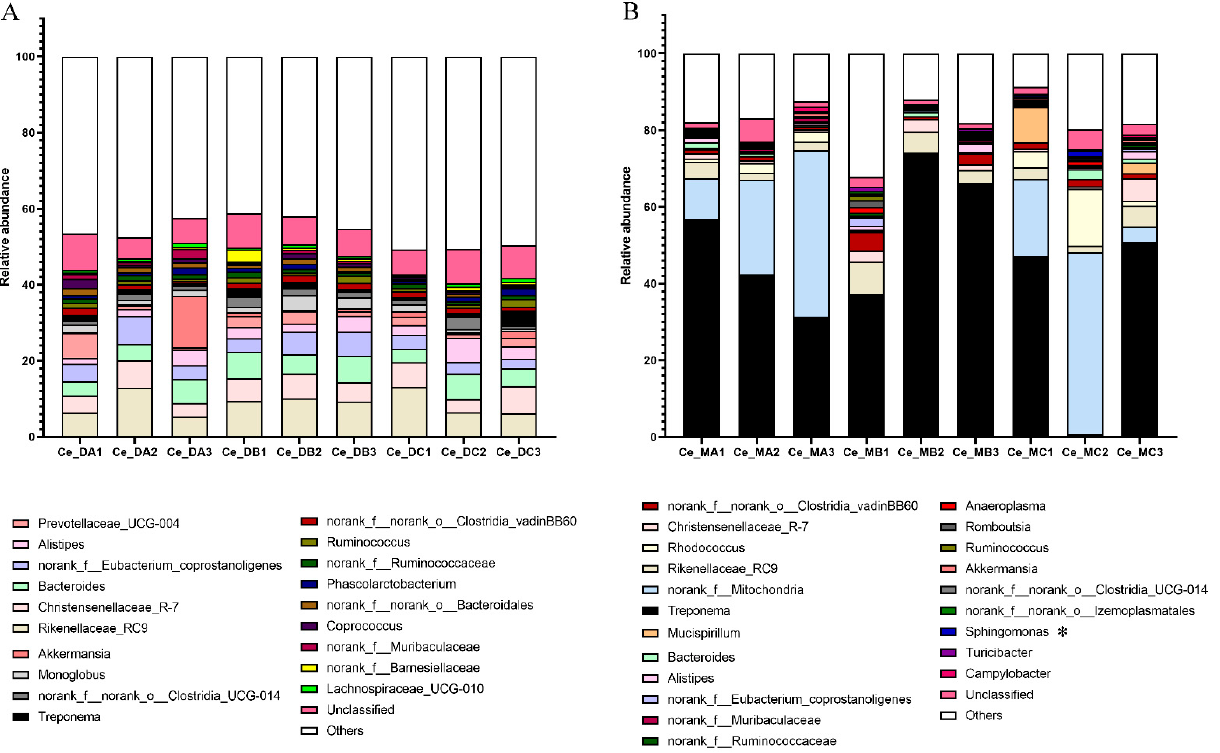
Figure 2. Effect of different nutritional levels on the abundance of bacteria in the genus level ( A ) in cecum digest, and ( B ) cecum mucosa. Bacteria with an abundance of less than 1% are classified as Others. “*” indicates 0.01 < p <